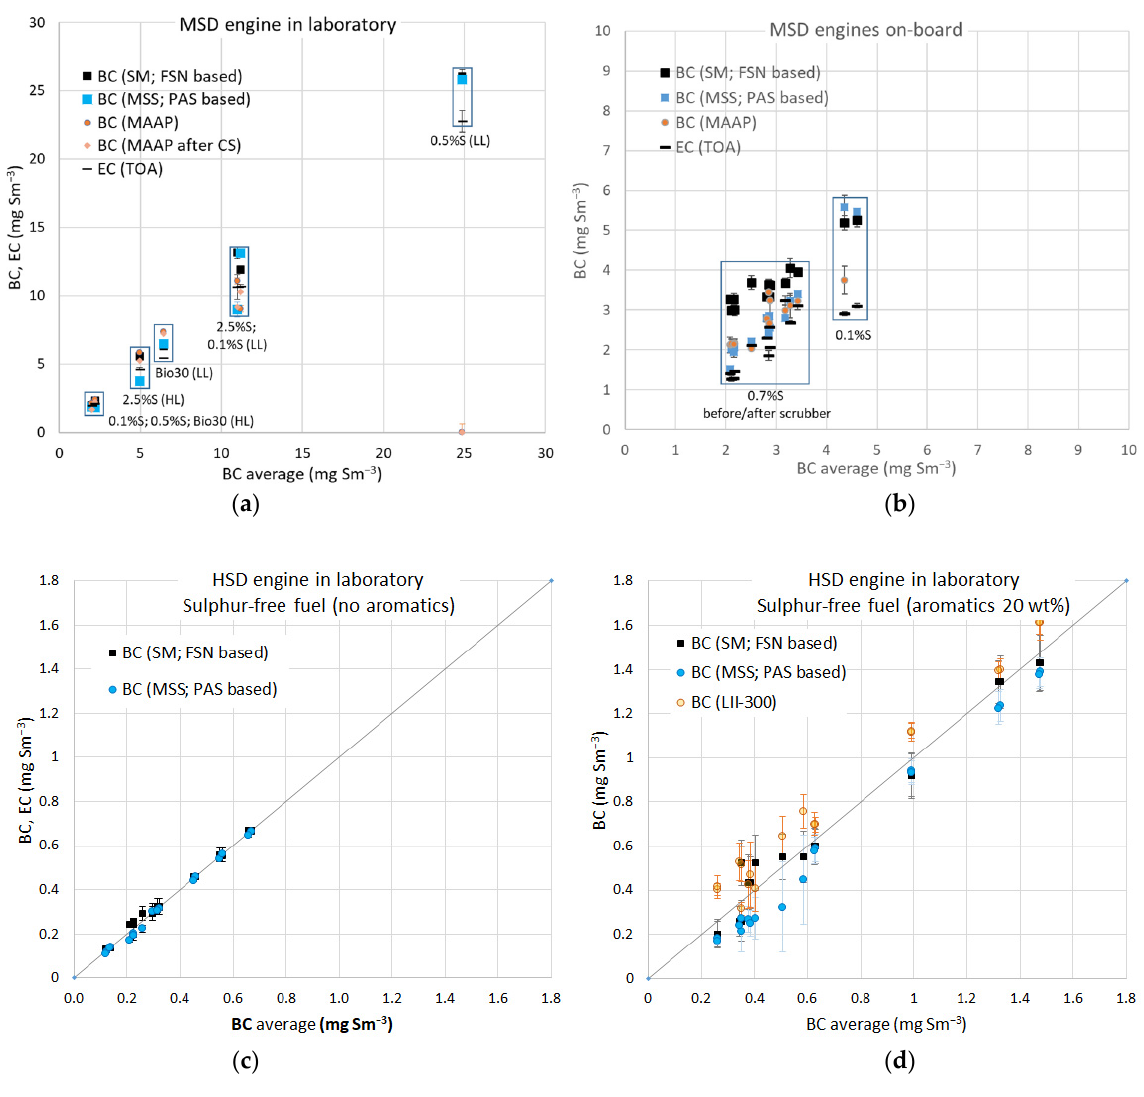
Figure 2. BC emissions measured from MSD engines ( a ) in a laboratory campaign A, ( b ) on-board campaign B, and from an HSD engine (campaign C) using ( c ) aromatic-free fuel and ( d ) fuel with aromatic content of 20 wt%. Average BC results from designated instrument and respective standard deviations of replicate tests (error bars) are on y-axis, and average BC results over different instruments (see Section 3.1.1) on x-axis. Boxes group the results obtained with different fuels and engine loads (LL = low engine load, HL = high engine load). CS designates catalytic stripper.